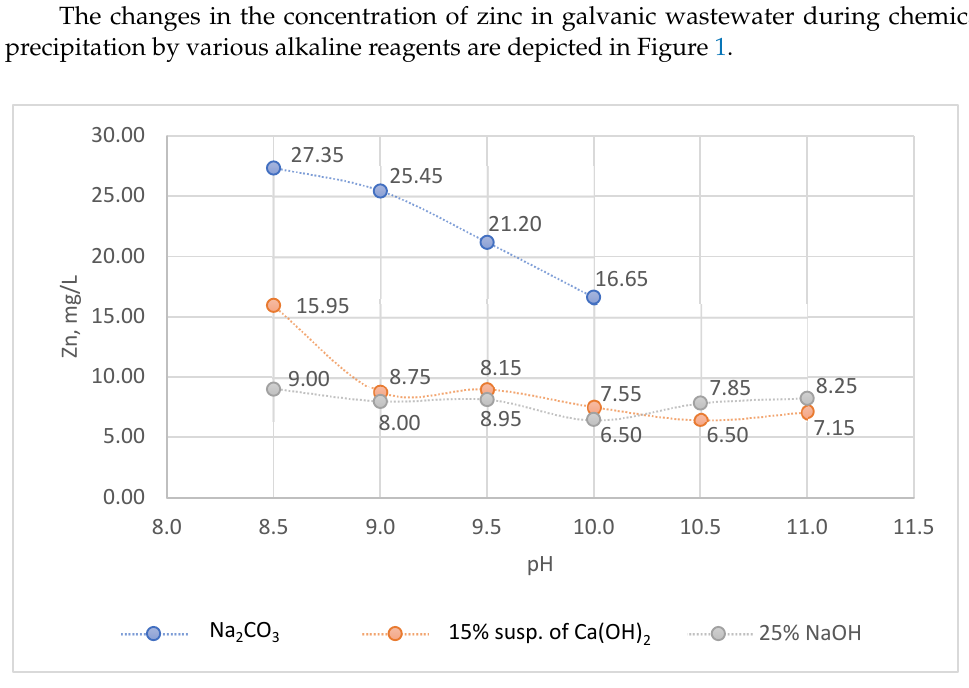
Figure 1. The concentration of zinc in concentrated galvanic wastewater treated by 20% solution of Na 2 CO 3 , 15% suspension of Ca(OH) 2 and 25% solution of NaOH (the pH value of the 20% solution of Na 2 CO 3 was 10.5 ±